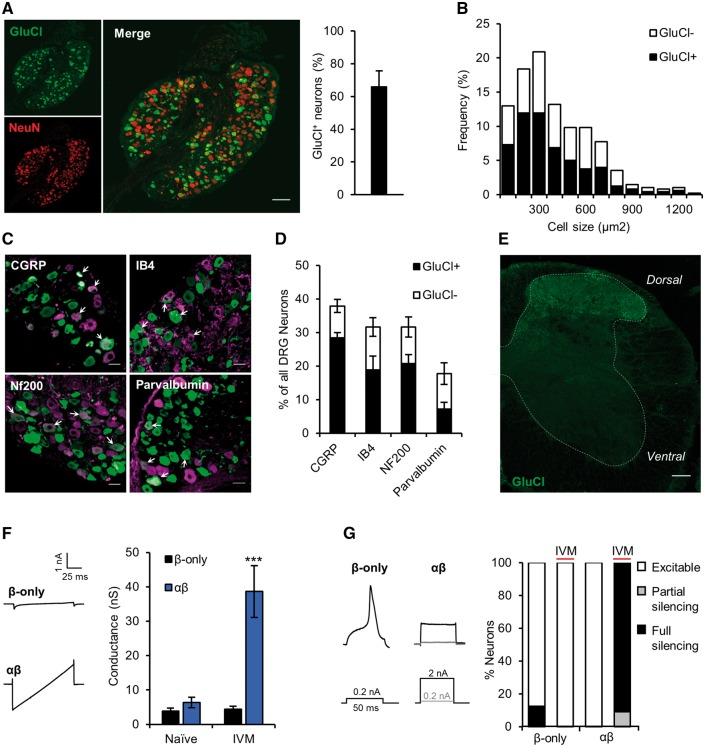

Intrathecal delivery of GluCl-AAV efficiently transduces sensory neurons. Analysis of tissue taken from animals 4 weeks following intrathecal co-delivery of AAV9-GluClα and AAV9-GluClβ. (A, left) L4 DRG immunostained for YFP (green) and NeuN (red). Scale bar = 100 μm. (Right) GluCl+ DRG as a proportion of total neurons. Data represent mean ± SEM from three animals and a total of 912 neurons. (B) Size distribution of GluCl+ neurons. Data pooled from three animals and represent a total of 379 cells. (C) GluCl (green) co-localization with DRG subpopulation markers (magenta). White arrows show double-labelled neurons. Scale bar = 30 µm. (D) Percentage of GluCl+ DRG in the different subpopulations. Data represent results from n = 3 animals and a total of >600 cells/group. (E) Representative lumbar spinal cord immunostained for YFP (n = 4 animals assessed). Scale bar = 100 µm. (F) Membrane conductance of ex vivo GluCl+ neurons taken from GluCl-AAV animals untreated (Naïve) and 24 h following 5 mg/kg i.p. ivermectin (IVM). (Left) Current traces in response to membrane voltage ramp −90 to −40 mV (0.5 mV/ms) of neurons from ivermectin treated animals. (Right) Quantification of membrane conductance. One-way ANOVA followed by post hoc Bonferroni test comparing groups to control (Naive β-only), naive β-only, n = 8; naïve αβ, n = 7; ivermectin β-only, n = 8; ivermectin αβ, n = 10. (G) Firing properties of GluCl-AAV animal derived GluCl+ neurons. (Left) Action potential traces in response to depolarizing current injection of DRG neurons derived from ivermectin-treated animals. (Right) Excitability status as defined by a rheobase value: <3 (excitable), 3–10 (partial silencing) or >10 (full silencing) standard deviations above the mean of control (Naïve β-only, mean = 160.1 ± 160.6 pA). P < 0.001, chi-squared test (χ2 = 32.52 with 6 degrees of freedom); Naive β-only, n = 8; Naïve αβ, n = 7; ivermectin β-only, n = 8; ivermectin αβ, n = 10. All averaged data represent the mean ± SEM. ***P < 0.001.